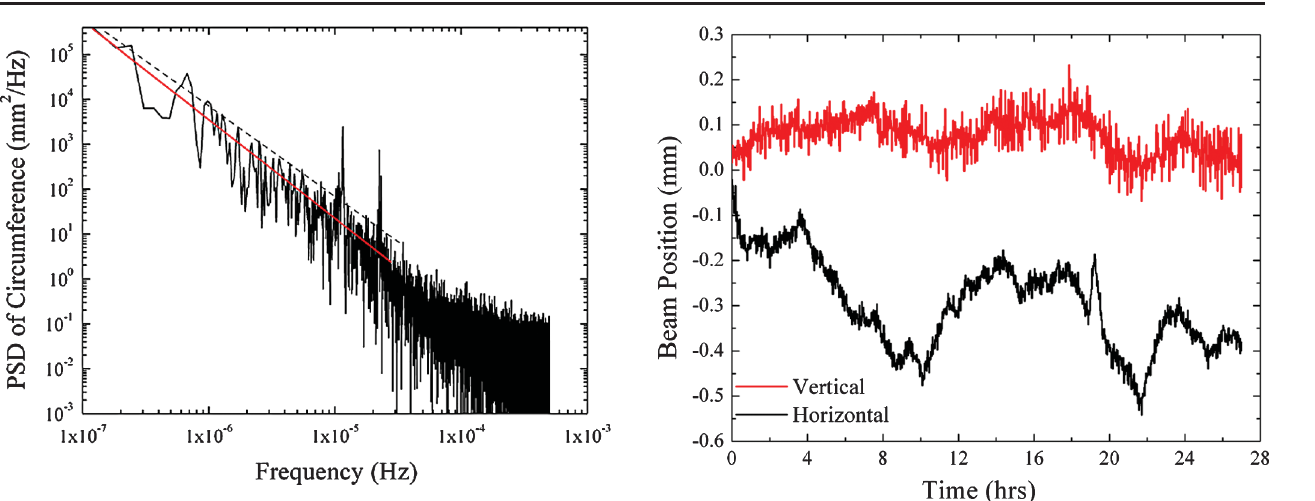
FIG. 8. (Color) Horizontal and vertical orbit motion as measured by one of the beam position monitors in the Tevatron